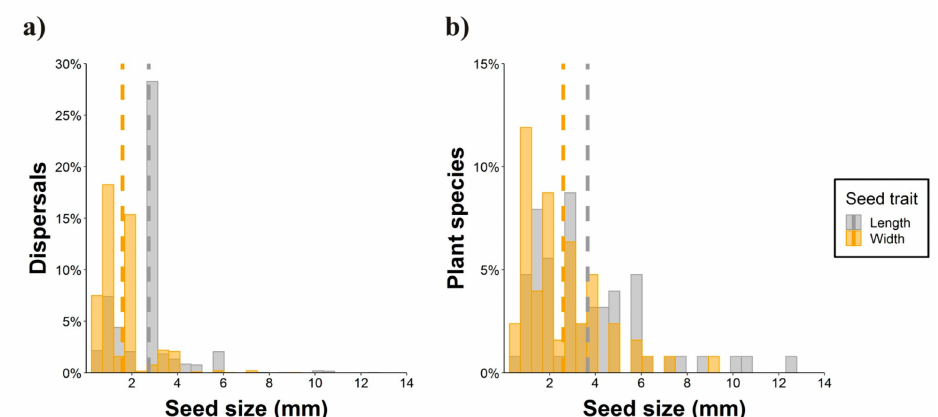
Figure 5. Size (length and width) of the seeds dispersed by parrots through epizoochory considering ( a ) the percentage of seed dispersal events ( b ) and the percentage of dispersed plant species. Dashed lines show the mean values of each seed